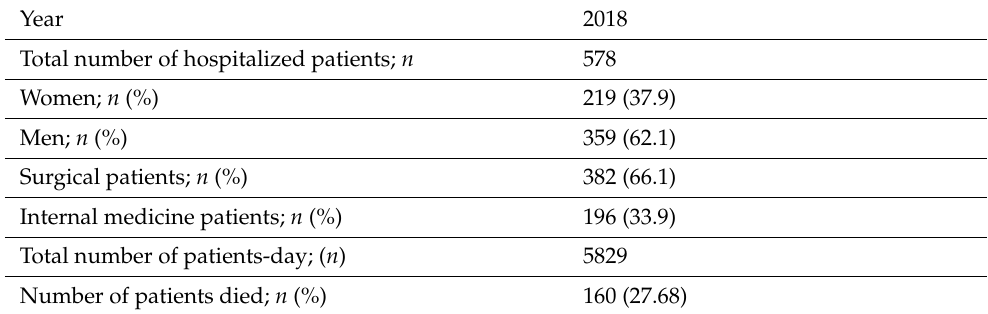
Table 1. Patients’ characteristics.